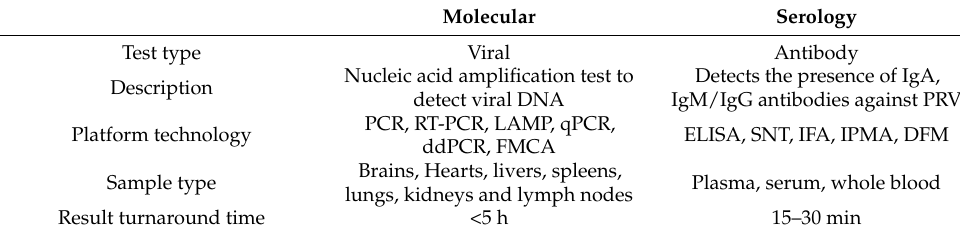
Figure 6. Flowchart of common diagnostic methods for PRV infection. Two types of common methods are used to verify the PRV infection based on the PRV-specific antibodies and nucleic acids. Among them, serological approaches for the detection of PRV infection include the enzyme-linked immunosorbent assays (ELISA), indirect immunofluorescence assay (IFA), serum neutralization test (SNT), direct-immunofluorescence method (DFM) and blocking immunoperoxidase monolayer assay (b-IPMA). Molecular biology approaches include polymerase chain reaction (PCR), real-time PCR (RT-PCR), TaqMan real-time PCR (qPCR), nano PCR, droplet digital PCR (ddPCR), real-time recombinase-aided amplification (RT RAA), loop-mediated isothermal amplification (LAMP), real-time fluorescent detection (real-time RPA assay), duplex fluorescence melting curve analysis (FMCA), next-generation sequencing (NGS), probe-based fluorescence melting curve analysis (FMCA), real-time recombinase-aided amplification assay (RT RAA) and third-generation sequencing (TGS). Table 1. Comparison of diagnostic methods of PRV infection.